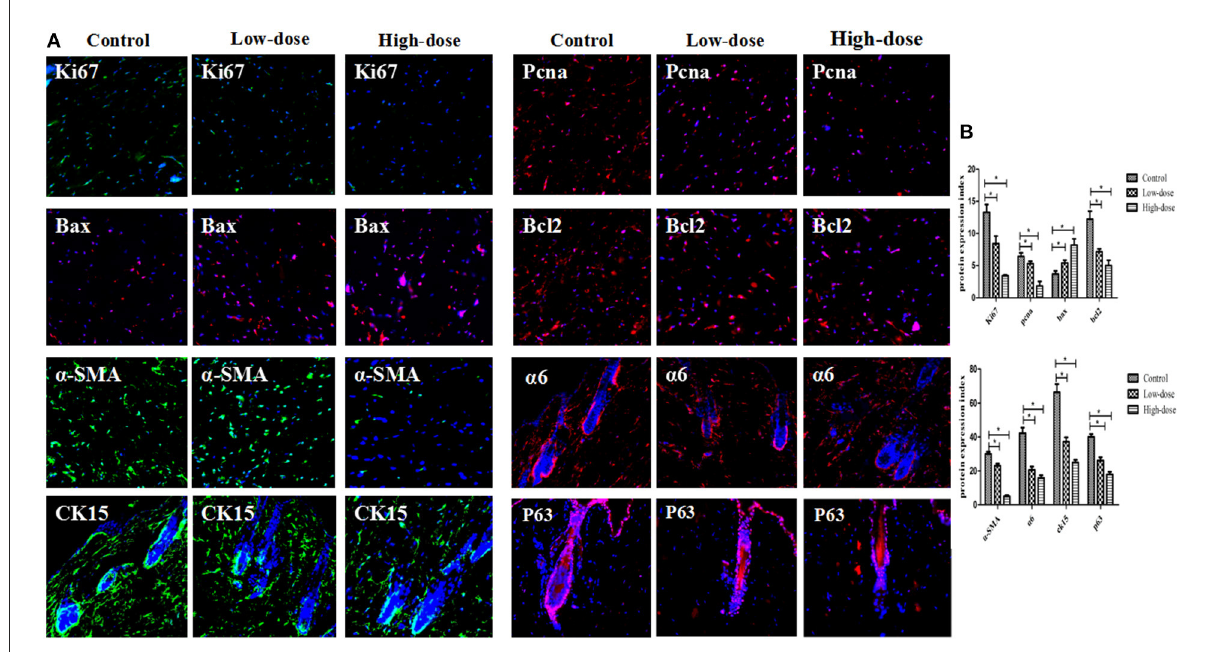
FIGURE8 (A) Immunofluorescence detection of markers in different groups (X200). (B) Comparison of immunofluorescence gray values of markers in different groups. Data are represented as means